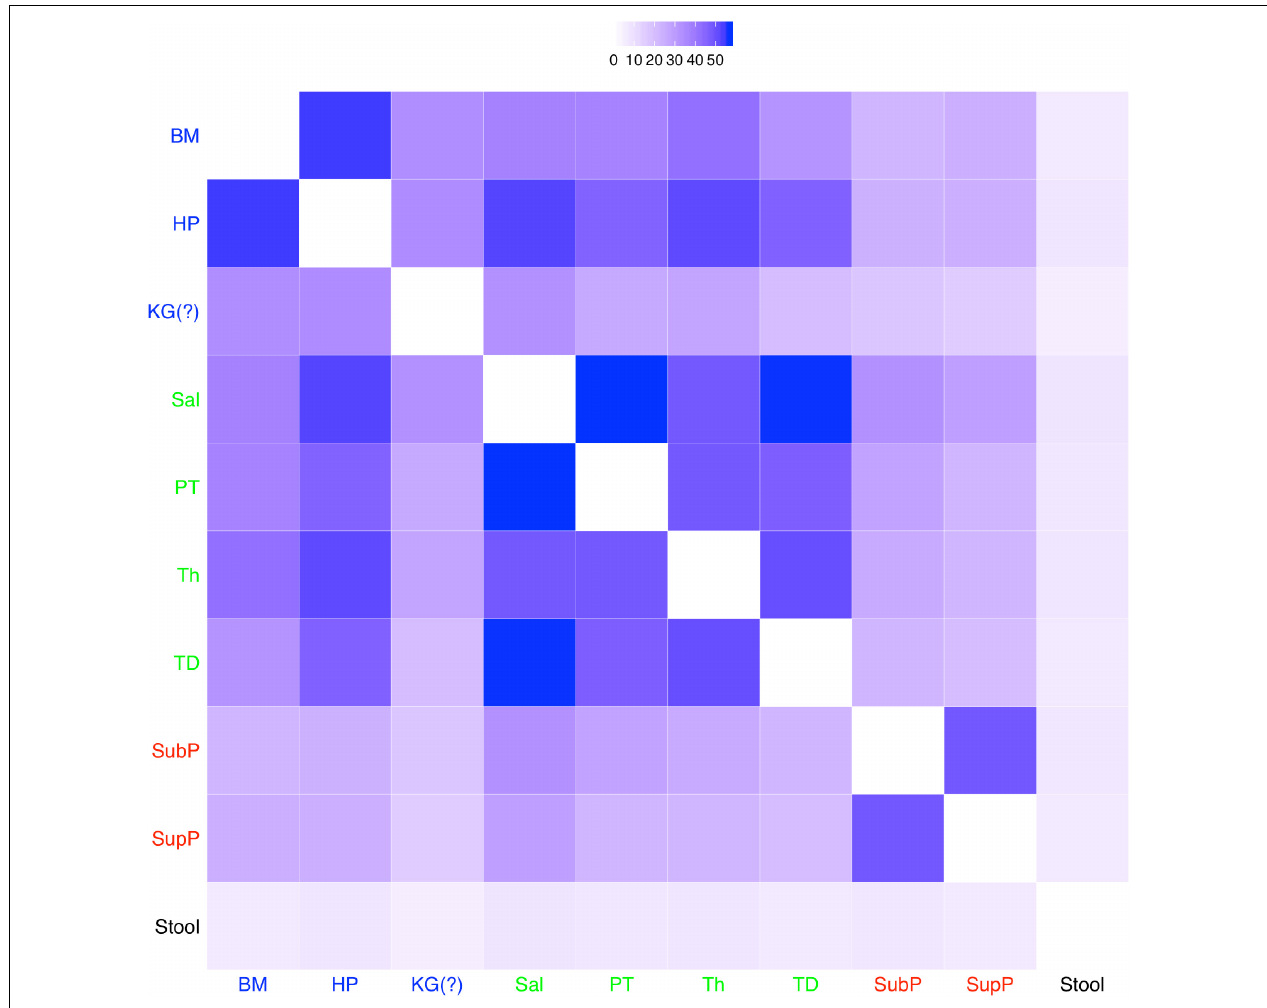
FIGURE 4 | A heatmap showing the M -value (the average medians of the migration rates of local communities in each metacommunity) of the 10 sites: the larger the M -value is (the deeper the color in the heatmap is), the higher the similarity between the DT sites (see Supplementary Table 3 for detailed results of other MSN parameter). A fifth niche, i.e., KG (keratinized gingival), together with the four niches (the four types of DT microbiota, i.e., “BM-HP-KG,” “Sal-PT-Th-TD,” “SubP-SupP,” and “Stool,” colored differently, and originally discovered by Segata et al. (2012)) emerged as five clusters here. The fifth niche (KG) was originally classified into the “BM-HP-KG” type by Segata et al.